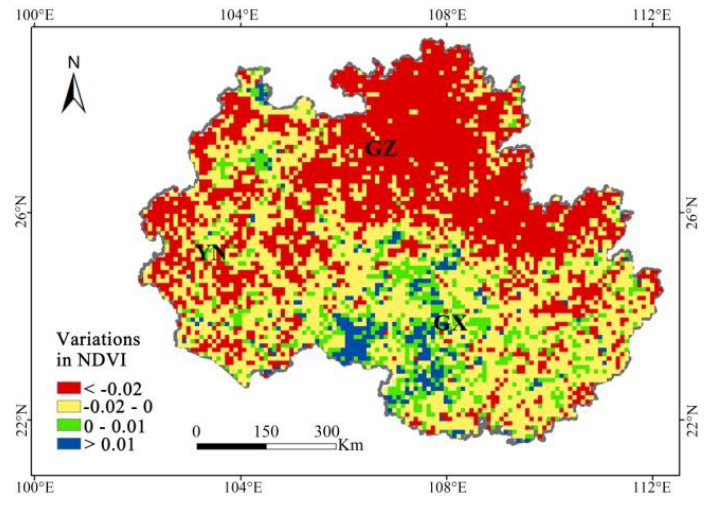
Figure 9. Spatial patterns of variations in growing-season NDVI during 2009–2012.